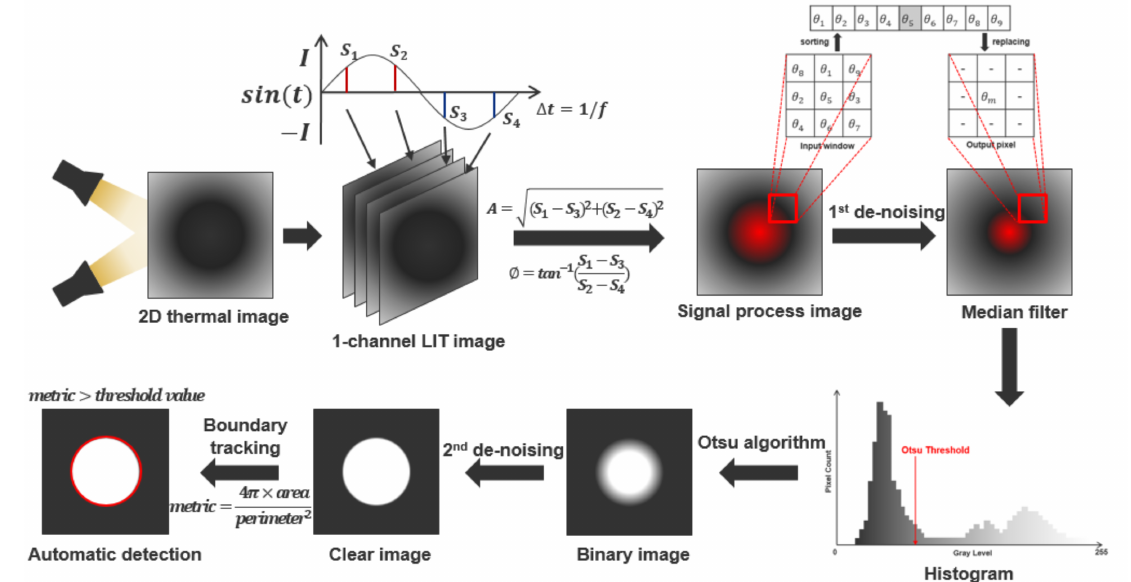
Figure 1. Flowchart of the overall research process of this